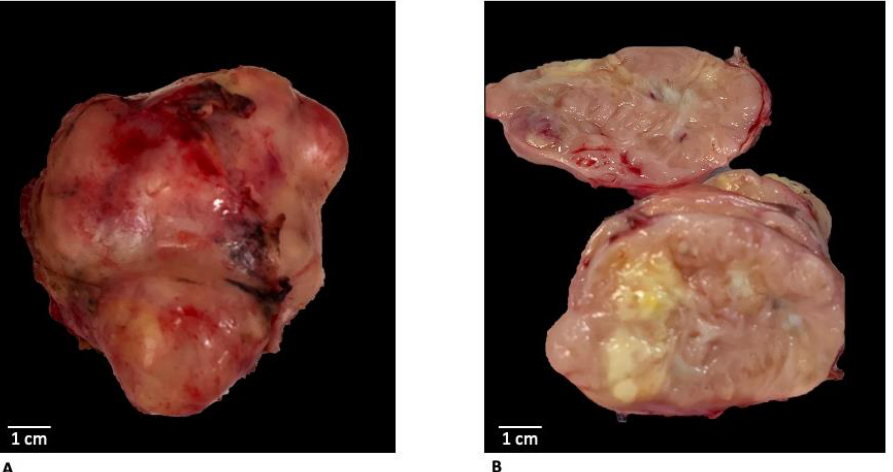
Figure 3. Macroscopic examination after surgical excision showed a large polylobate irregularly shaped mass ( A ) tan to brown with a sharp margin and smooth profile; the cut surface ( B ) showed a whorled pattern admixed with yellowish areas of necrosis and areas of hemorrhage.